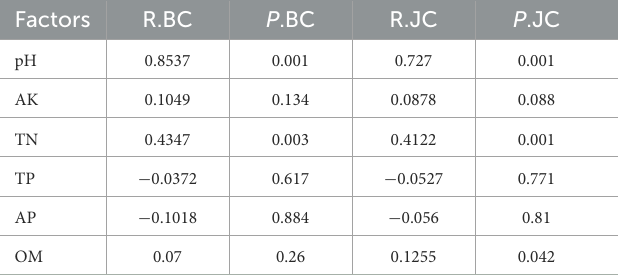
TABLE 2 The mantel test result between environmental factors and bacterial communities based on Bray-Curtis and Jaccard distances.